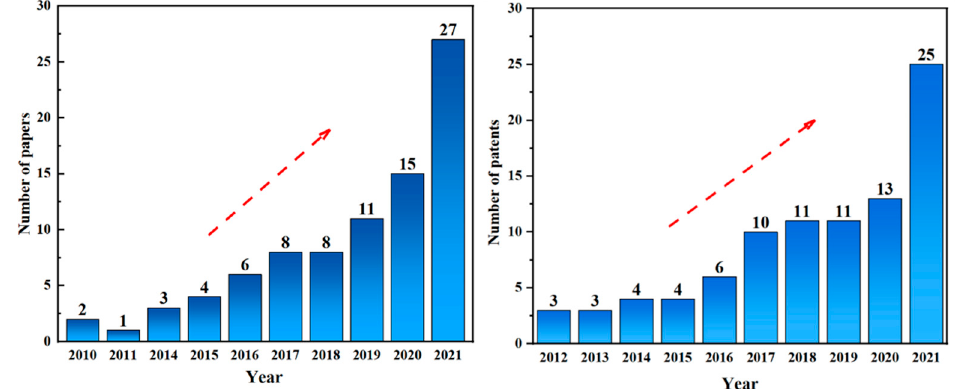
Figure 2. The number of papers and patents published on ASP geopolymers in recent years.